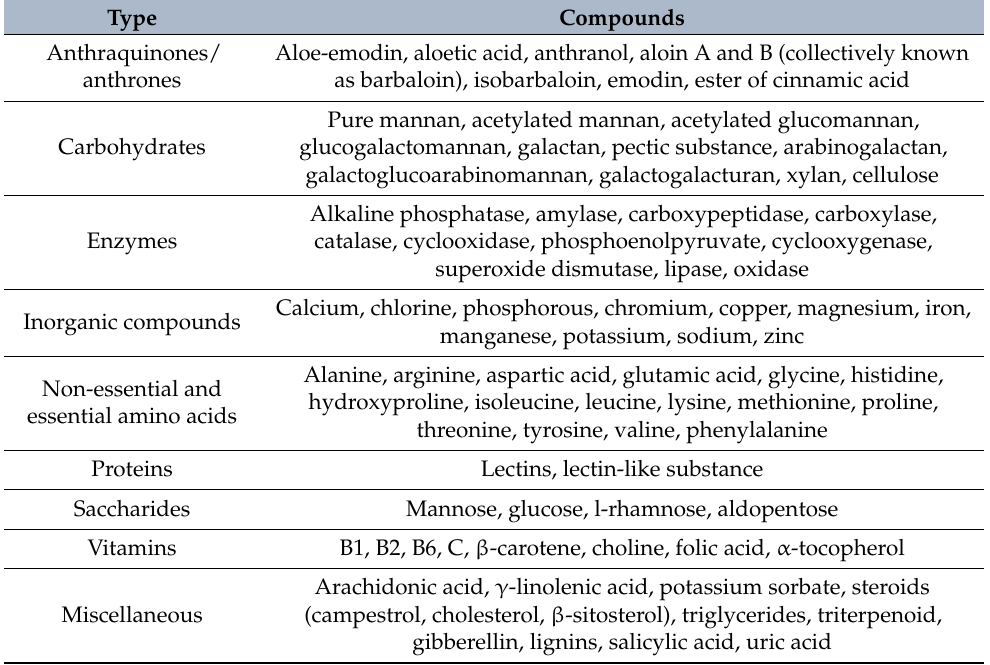
Table 1. Components of Aloe vera . Adapted with permission from [6].